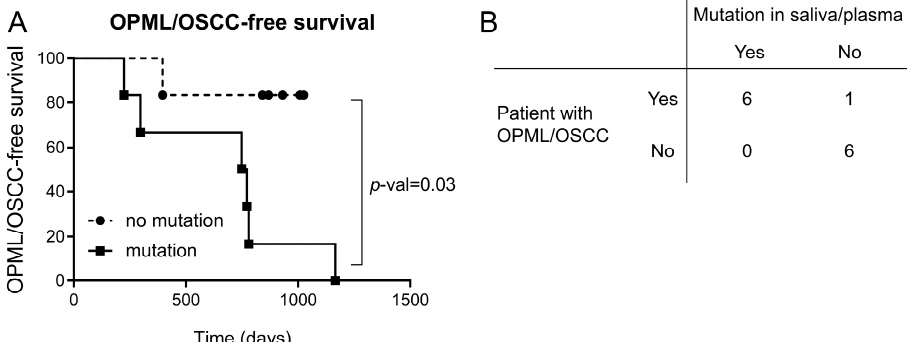
Figure 5. ( A ) Kaplan–Meier curves of FA patients with or without mutations. FA patients with mu- tations display signi fi cantly higher risk of developing OPML or OSCC than patients without muta- tions. Statistically signi fi cance di ff erences between curves were determined using log rank test. ( B ) Accuracy of the detection of mutations in saliva/plasma as diagnostic for FA patients that develop OPML or OSCC. Global accuracy: 92%; sensitivity: 86%; speci fi city: